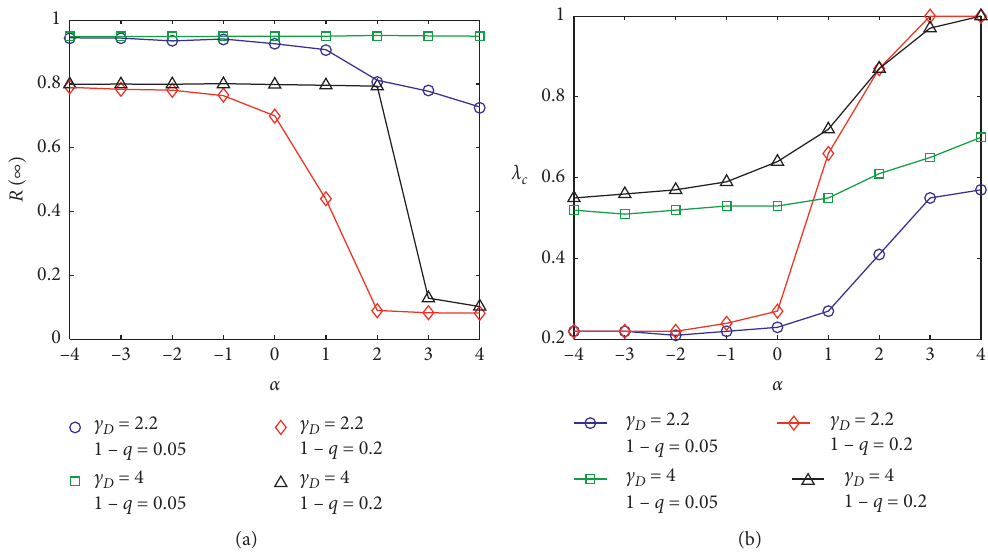
Figure 2: The effects of the immune index α on social contagions under different degree exponent c adoption size R ( ∞ ) versus α when λ � 1 and (b) the threshold λ c versus α .